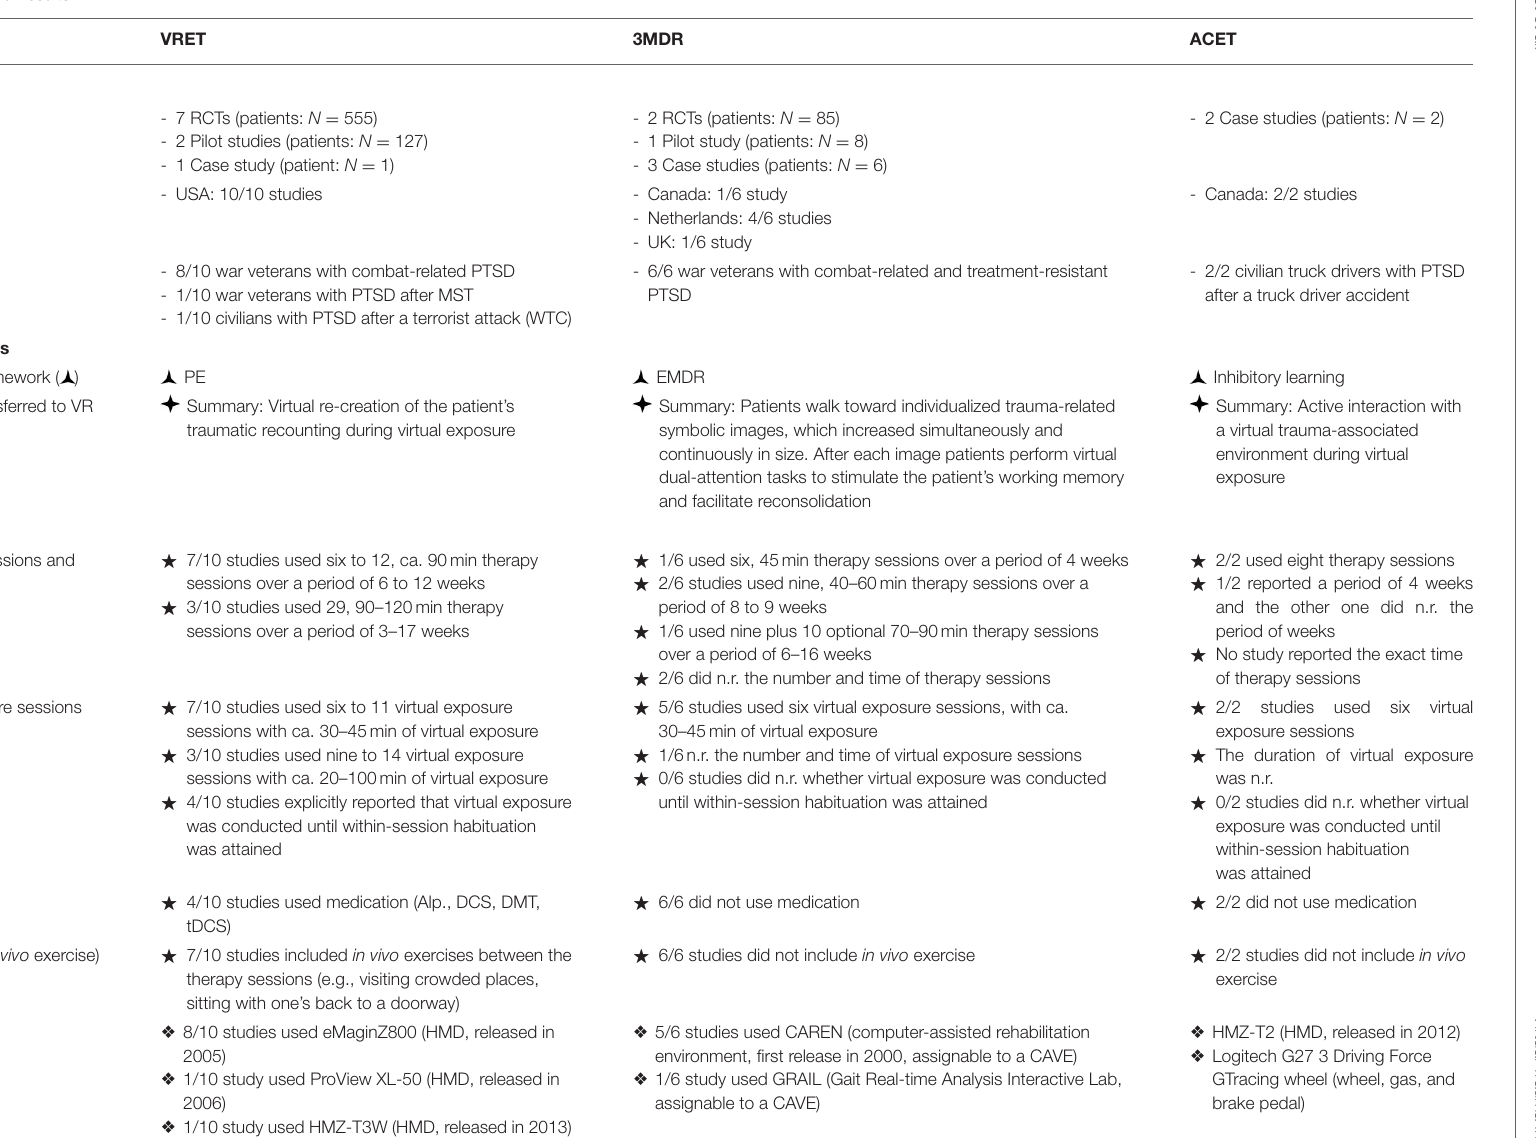
TABLE 3 | Overview of